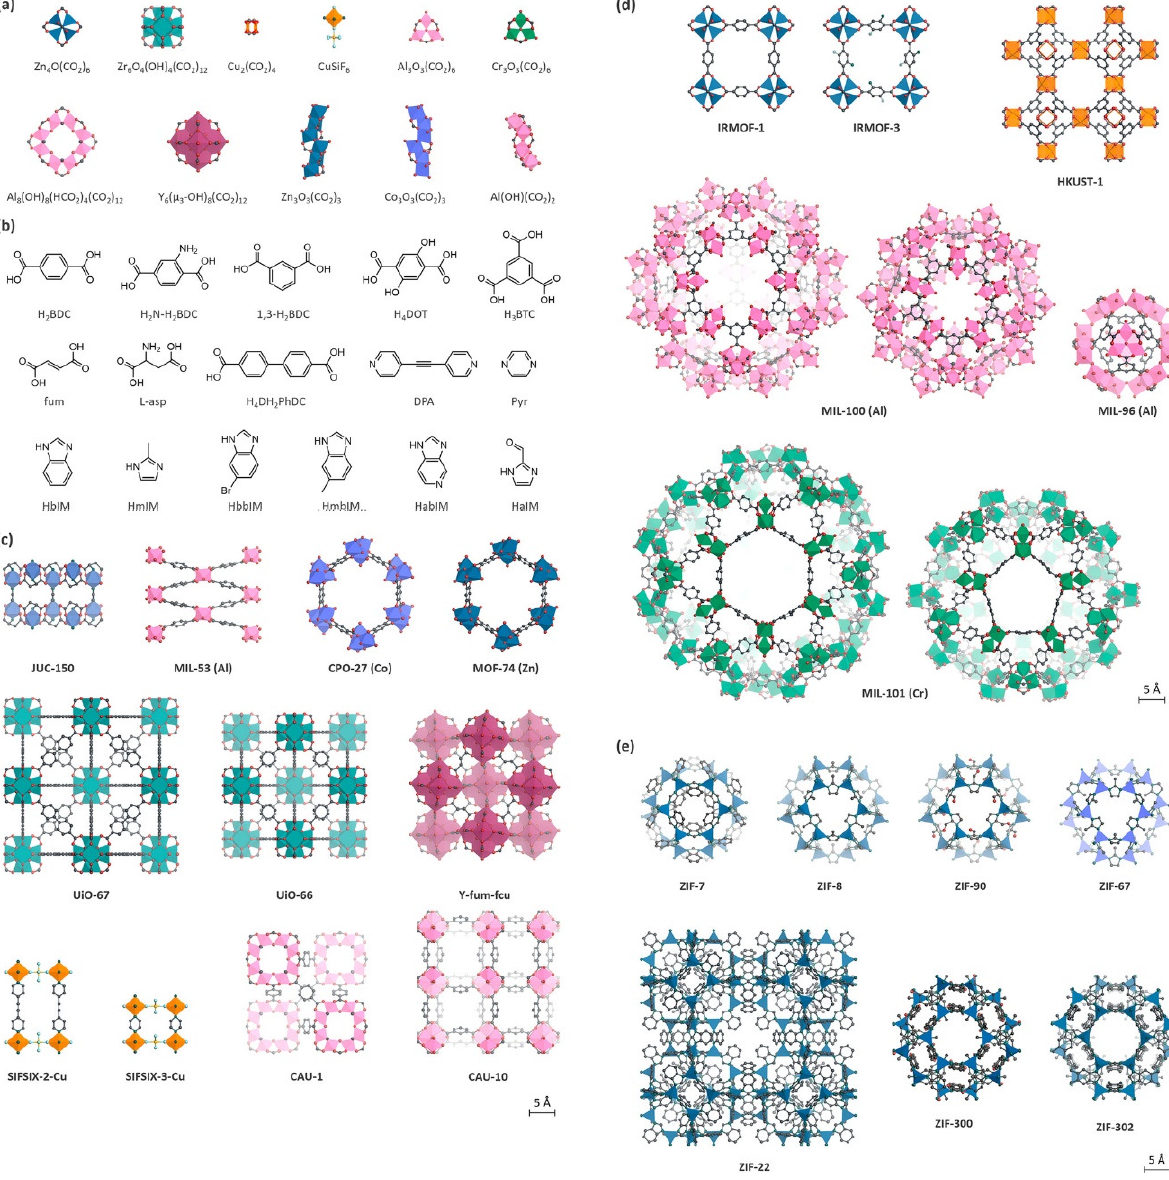
Figure 5. Representative MOFs for mixed matrix membrane developments. ( a ) Inorganic secondary building units (SBUs) and ( b ) organic linkers of MOFs. ( c – e ) MOF structures of particular interest to membrane-based gas separation applications. Reprinted with permission from [84], copyright 2020 ACS.